Question: What style of plot is this figure drawn as?
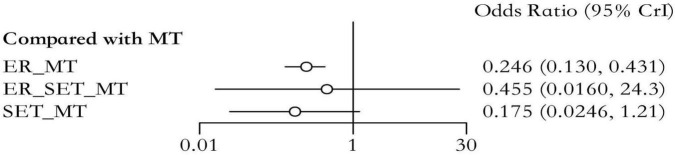
Answer: forest